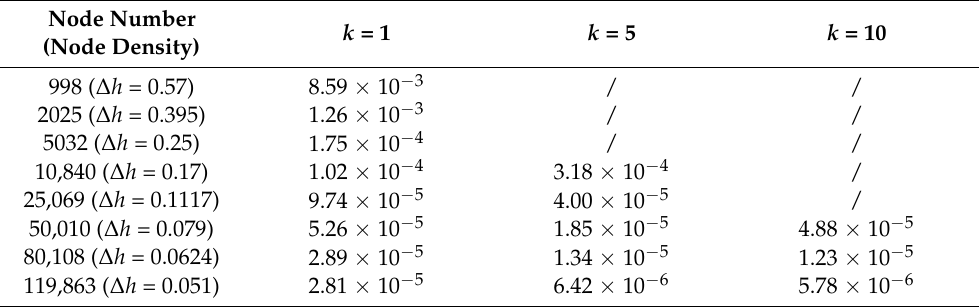
Table 3. Numerical errors (L 2 ) in the reliable region obtained by the proposed LCTM + absorbing boundary conditions based on wave expansion functions (ABCWEF) with respect to the increasing node number and wavenumber.